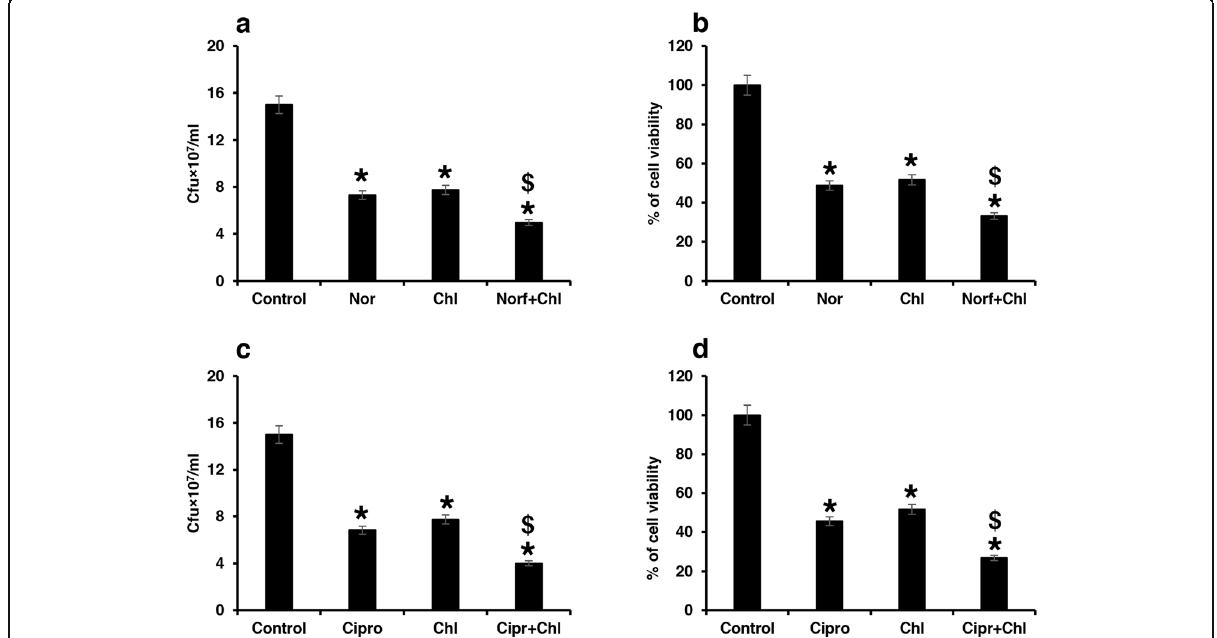
Fig. 4 The cfu/ml count ( a ) and % of cell viability ( b ) in the synergistic effect of methanol extract of the C. vulgaris with norfloxacin. A similar cfu/ ml count ( c ) and % of cell viability ( d ) in the synergistic effect of methanol extract of the C. vulgaris with